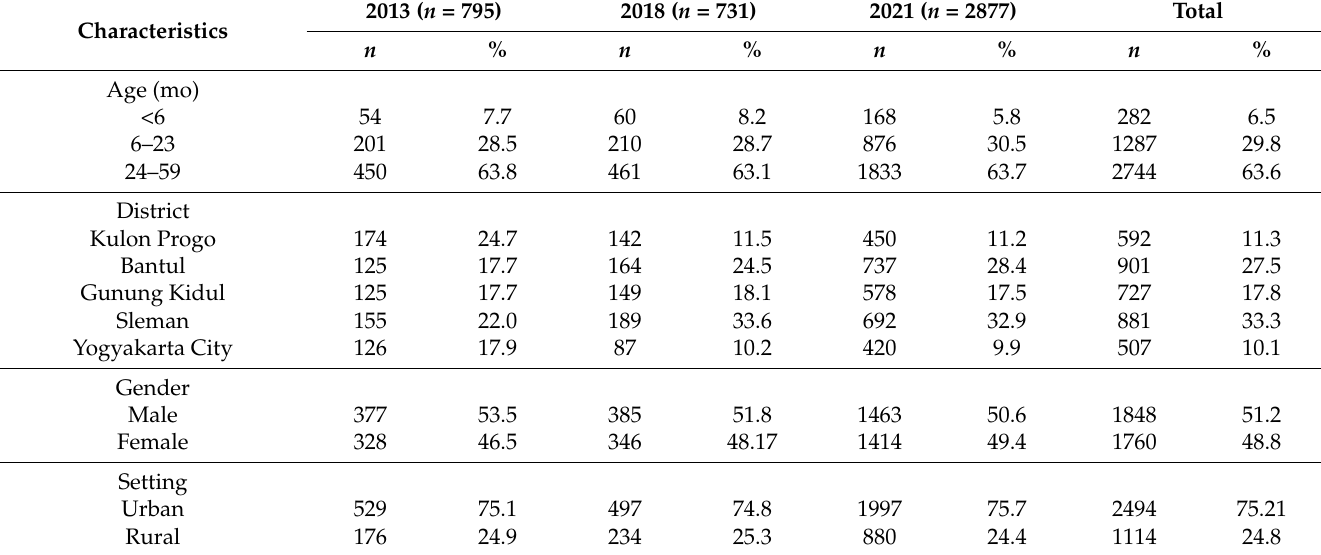
Table 1. Sample characteristics.